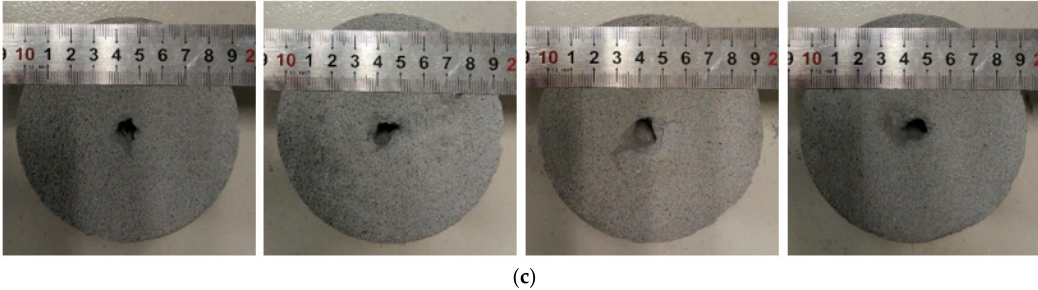
Figure 5. Photos of rock specimens after erosion: ( a ) Specimens eroded by the convergent nozzle; ( b ) Specimens eroded by the Laval-1 nozzle; ( c ) Specimens eroded by the Laval-2 nozzle.